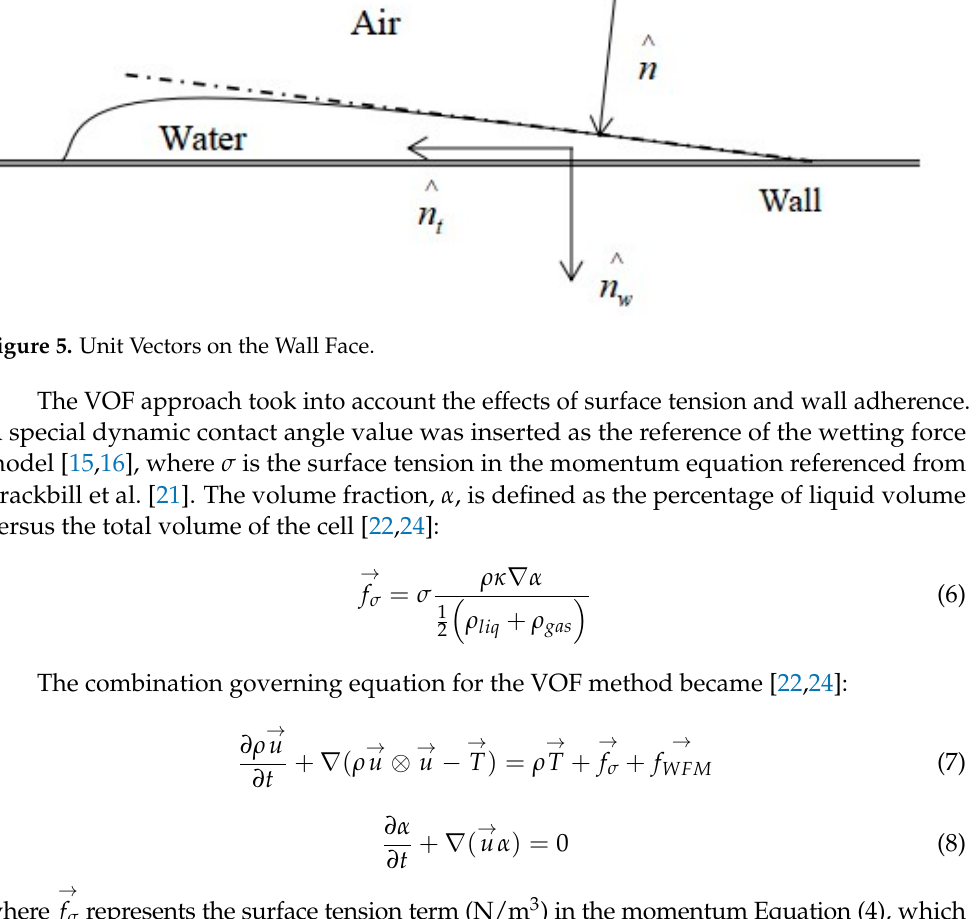
8 of 23 Figure 4. Receding and Dynamic Contact Angle for Hydrophilic Surface: ( a ) Experimental Record Contact Angle; ( b ) Schematic Diagram of Contact Angle Concept in Simulation Model. In Figure 4, where θ rec is the static contact angle, θ dyn is the dynamic contact angle, and θ